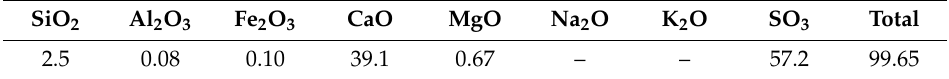
Table 6. Chemical compositions of anhydrite (unit: